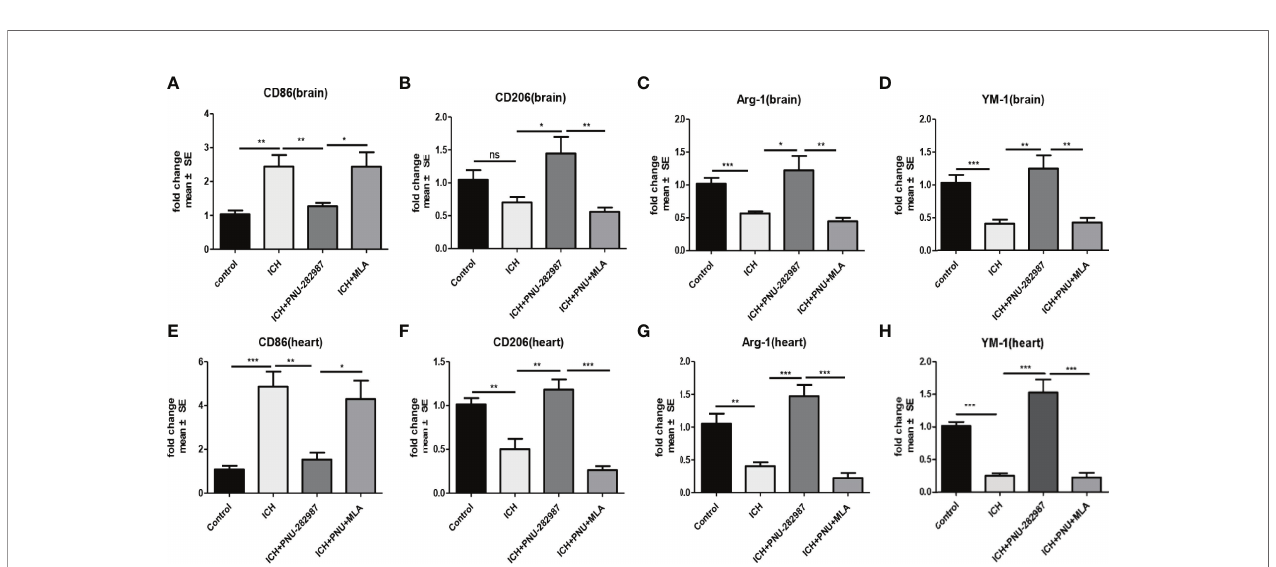
FIGURE 8 | The results of PCR demonstrated that PNU-282987 drastically decreased the phenotype of pro-in fl ammatory macrophages [CD86 (A) ] and increased anti-in fl ammatory macrophages [CD206 (B) , Arg-1 (C) , YM-1 (D) ] in brain. PCR results indicated that PNU-282987 signi fi cantly reduced the pro-in fl ammatory macrophages [CD86 (E) ] and increased the phenotype of anti-in fl ammatory macrophages [CD206 (F) , Arg-1 (G) , YM-1 (H) ] in heart. n= 6 per group for echocardiography. Data are presented as mean ± SE; *p < 0.05; **P < 0.01; ***P < 0.0001; ns means p >